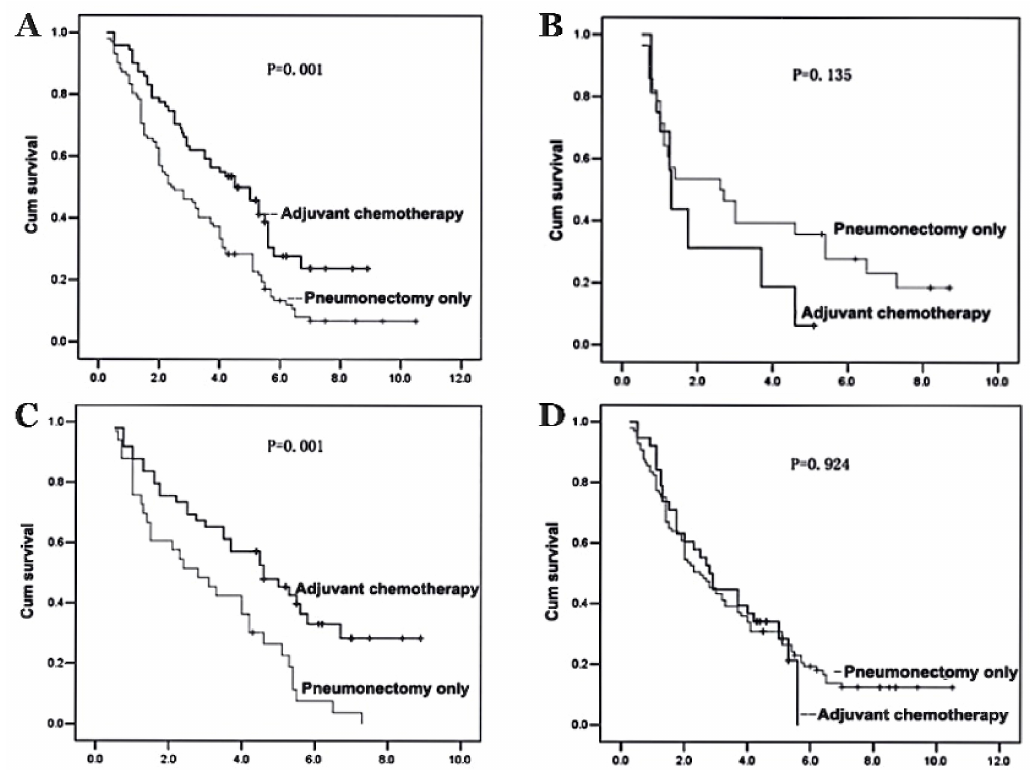
Figure 1. The outcomes of adjuvant chemotherapy in non-small cell lung cancer (NSCLC) patients depending on pneu- monectomy sites and preoperative pulmonary function are shown in Kaplan–Meier actuarial overall survival. ( A ) Patients after a left-sided pneumonectomy and adjuvant chemotherapy vs. pneumonectomy only. ( B ) Patients after a right-sided pneumonectomy and adjuvant chemotherapy vs. pneumonectomy only. ( C ) Patients with preoperative FEV1 ≥ 21 in adjuvant chemotherapy vs. pneumonectomy only. ( D ) Patients with preoperative FEV1 < 21 in adjuvant chemotherapy vs. pneumonectomy only. Adapted from [34]. Copyright 2012 Spandidos